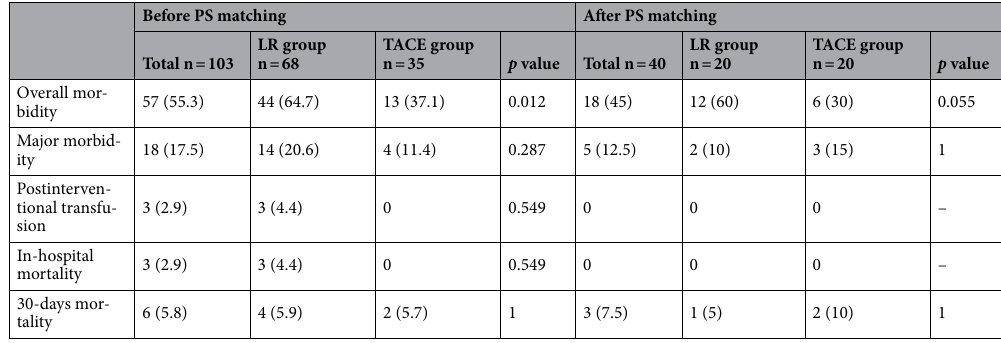
Table 3. Short-term treatment outcome before and after propensity score matching. Values are expressed as absolute number (percentage). PS propensity score, LR liver resection, TACE transarterial chemoembolization.